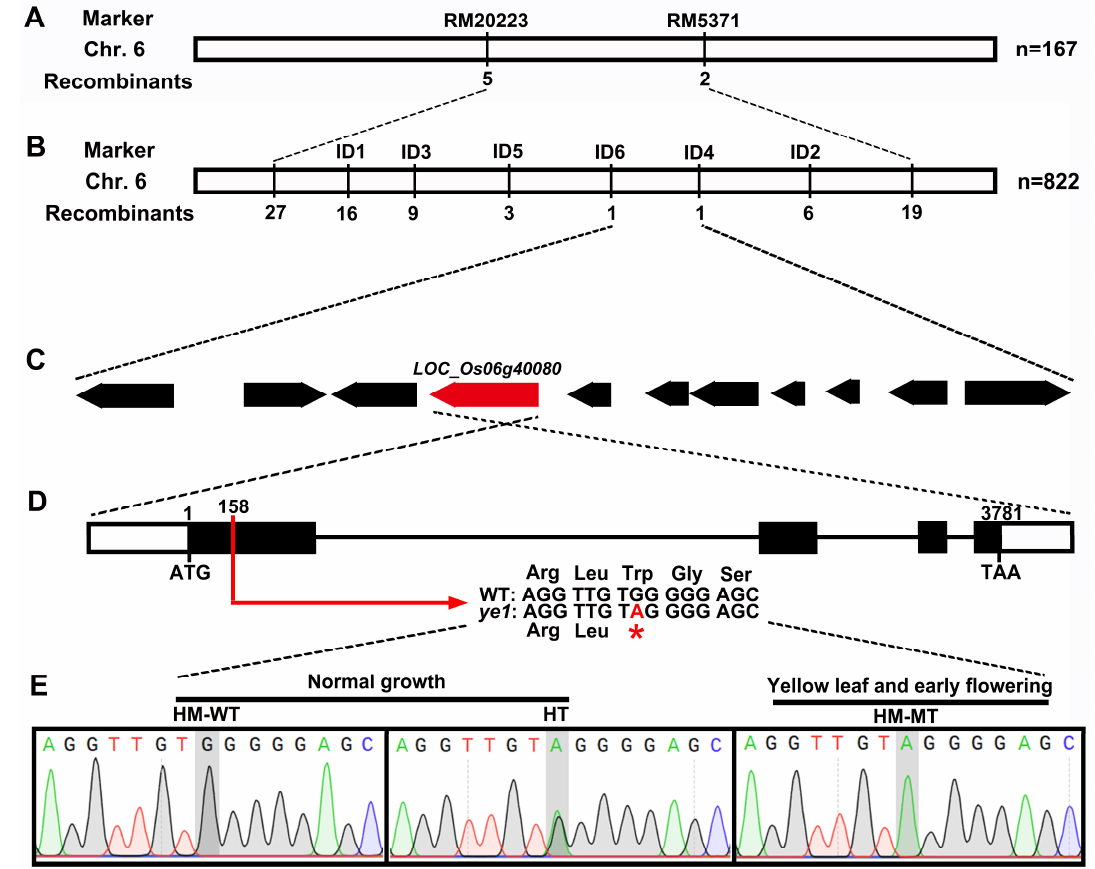
Figure 3. Map-based cloning and identification of the YE1 gene. ( A ) The YE1 locus was mapped to the interval between molecular markers RM20223 and RM5371 on chromosome 6. ( B ) The YE1 locus was further delimited to a ~85 kb genomic region between markers ID4 and ID6. ( C ) The candidate region contained eleven ORFs. ( D ) The gene structure of candidate LOC_06g40080. The red arrow indicates the ye1 mutation at 158 nucleotide position in LOC_06g40080 , which changes Ter at position 53 to a stop codon. The asterisk indicates the stop codon. ( E ) The identification of the YE1 gene in the ye1/WT F 2 population by sequencing.